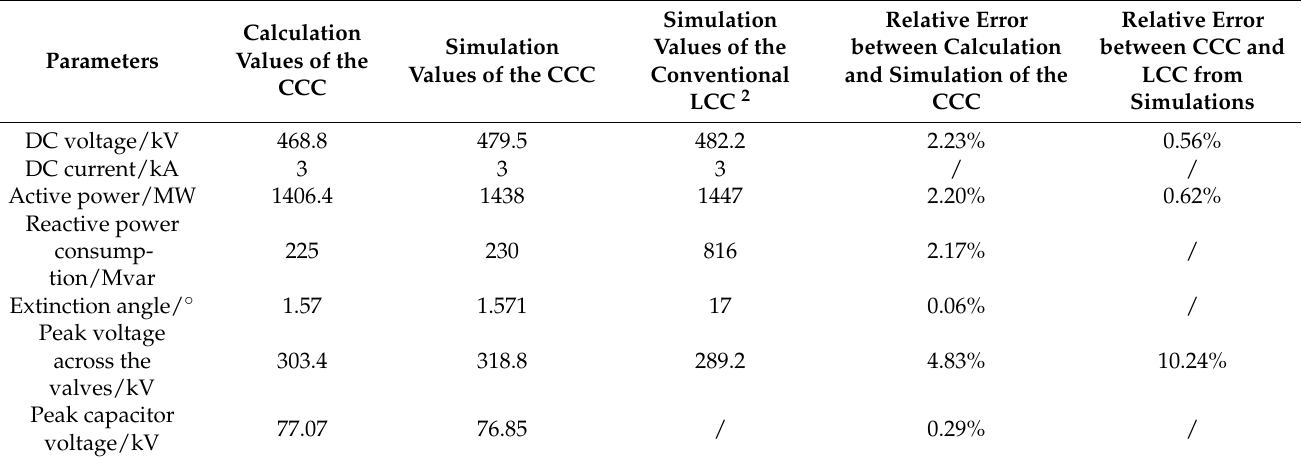
Table 8. Comparison of the simulation and calculation results (DC power is selected as 1.0 pu).